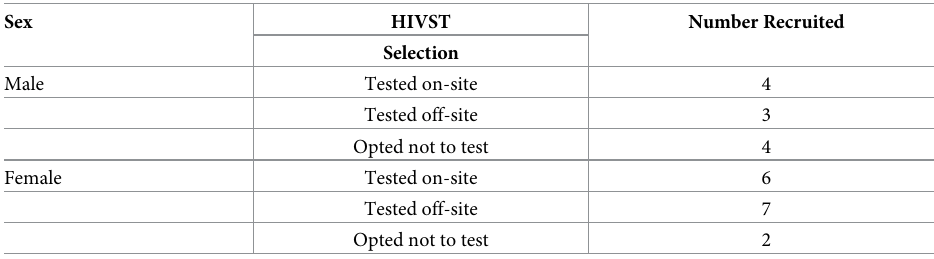
Table 1. Purposive sampling framework of IDI